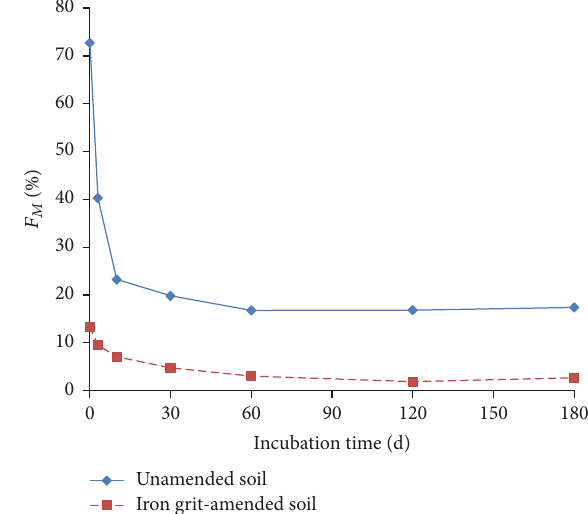
Figure 2: Changes of As bioaccessibility in soils under anoxic conditions (unamended soil, S N ; iron grit amended, S IN